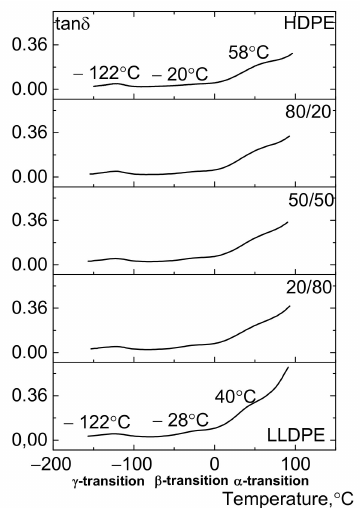
Figure 17. The effect of LLDPE on the loss modulus of HDPE/LLDPE blends